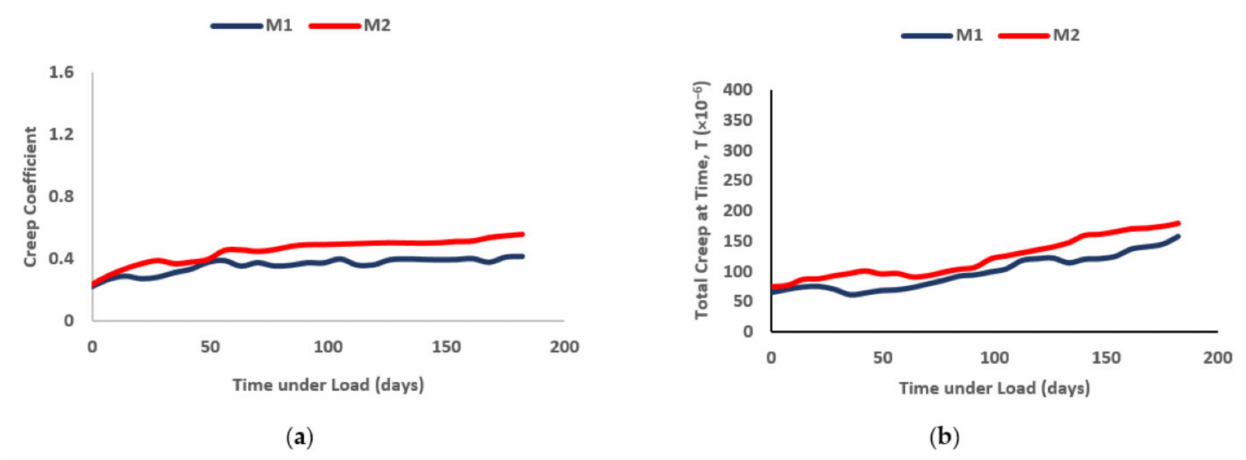
Figure 4. ( a ) Creep strain and ( b ) creep coefficient of rubberized ECC containing